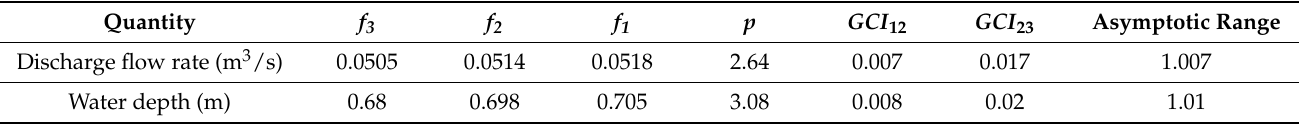
Table 3. Grid convergence index (GCI)